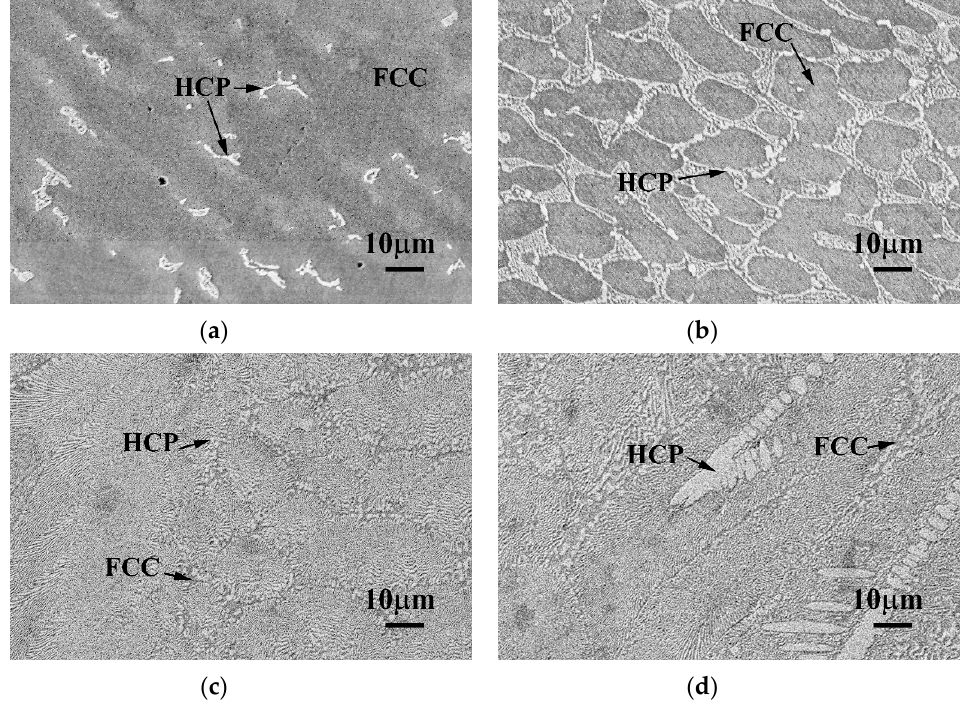
Figure 3. Scanning electron microscope backscattered electron image (SEM BEI) microstructures of the as-cast CoCrFeNiTa x alloys. ( a ) Ta 0.1 alloy; ( b ) Ta 0.3 alloy; ( c ) Ta 0.5 alloy; and ( d ) Ta 0.5 alloy with some primary HCP dendrites. The brighter phase had a higher average atomic number, i.e., the Ta content in the brighter phase (HCP) was higher than in the darker phase (FCC). Table 3. Overall chemical compositions and phase compositions (wt.%) of as-cast CoCrFeNiTa x alloys analyzed by SEM/EDS.